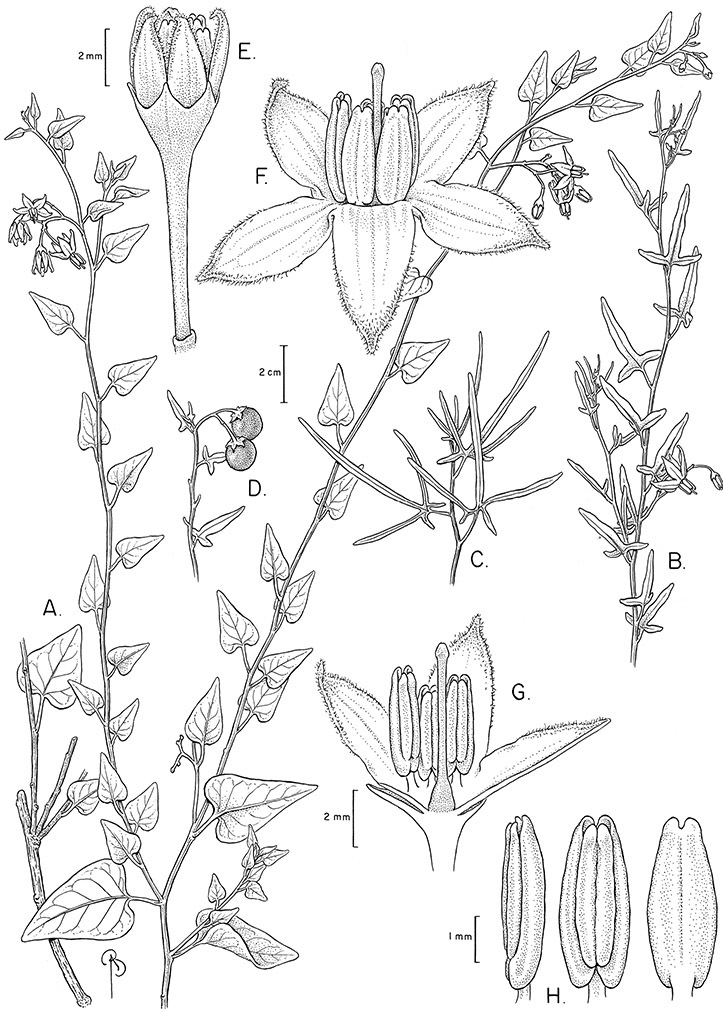
Solanum triquetrum Cav. (A drawn from Lindheimer 1044
B drawn from Chiang 7857
C drawn from Waterfall 6278
D drawn from Pringle 153
E–H drawn from Burr 452). Illustration by Bobbi Angell.